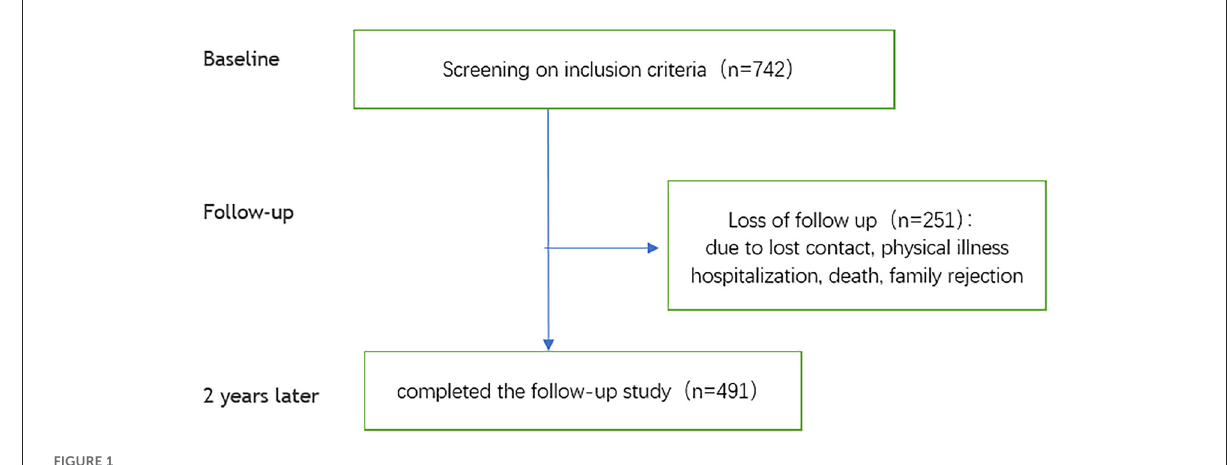
FIGURE1 Flowchart of the study participants.